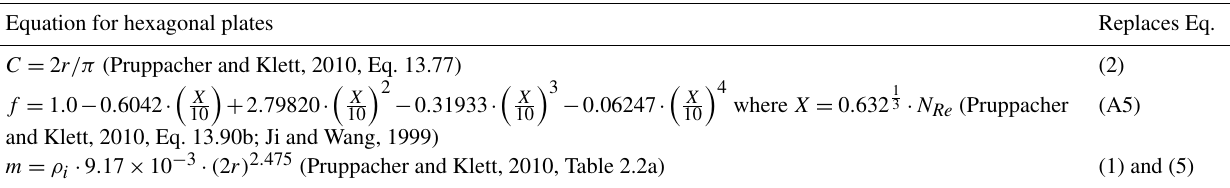
Table A4. Same as Table 2 but for hexagonal plates. Only those constants that differ from Table 2 are shown. Symbol Value coefficient for the velocity–mass relation for cloud ice (Seifert and Beheng, 2006, Table 1) coefficient for the velocity–mass relation for cloud ice (Seifert and Beheng, 2006, Table 1) 0 . 363 coefficient for the velocity–mass relation for cloud ice (Seifert and Beheng, 2006, Table 1) density of ice (Pruppacher and Klett, 2010, Table 2.3)